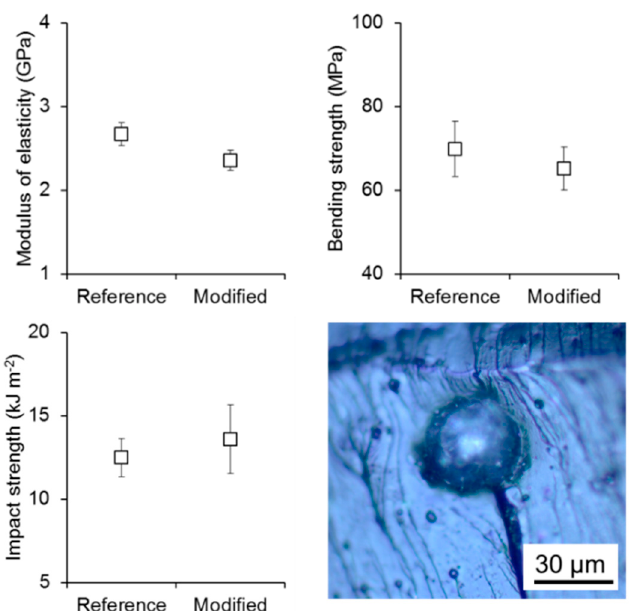
Figure 6. Results of the mechanical characterisation of sheets obtained from cured unsaturated polyester resin. While the unsaturated polyester resin was used as received in the reference material, the modified variant contains 1% filler consisting of polyester microspheres and MFLC fibrils at a ratio of 95/5. The microscope image shows the fracture surface of three-point bending samples, with the inset showing one polyester microsphere located at the fracture surface.